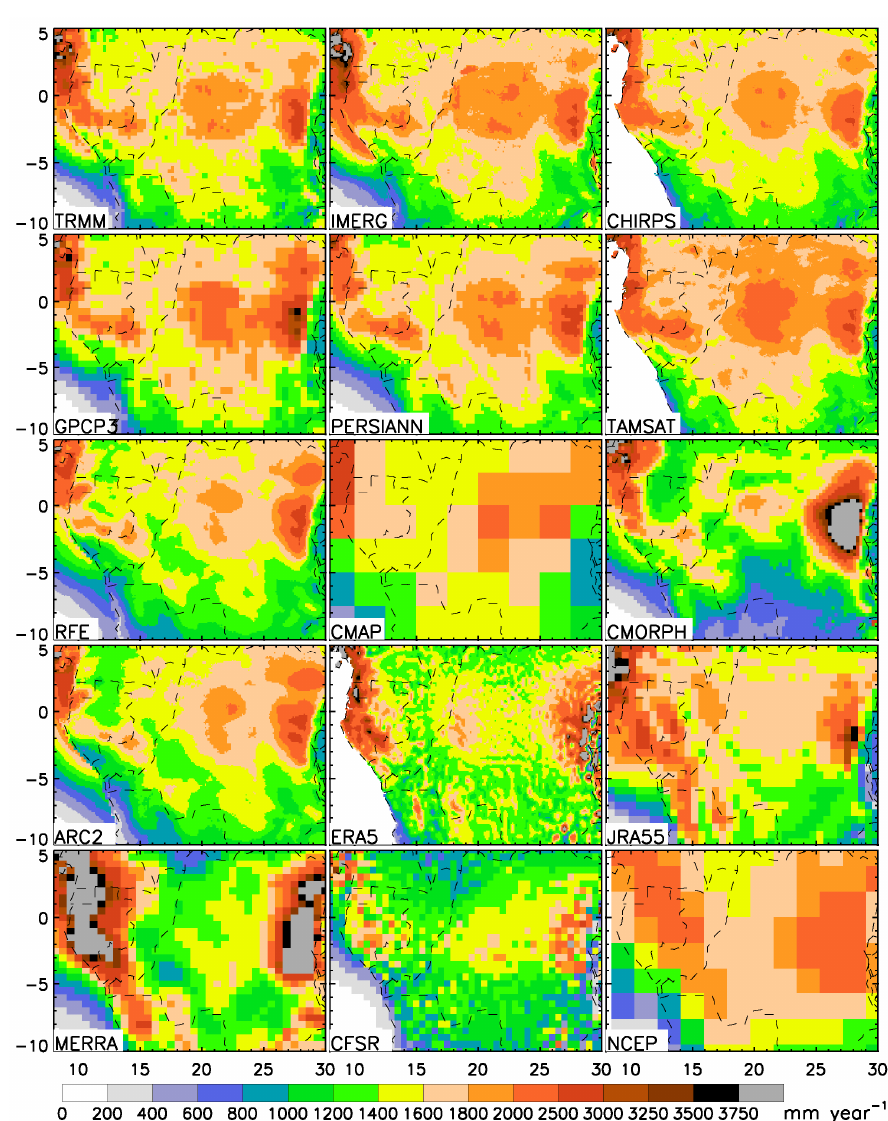
Figure 6. Mean annual rainfall (2001–2019) over the Congo region from fifteen satellite and reanalysis